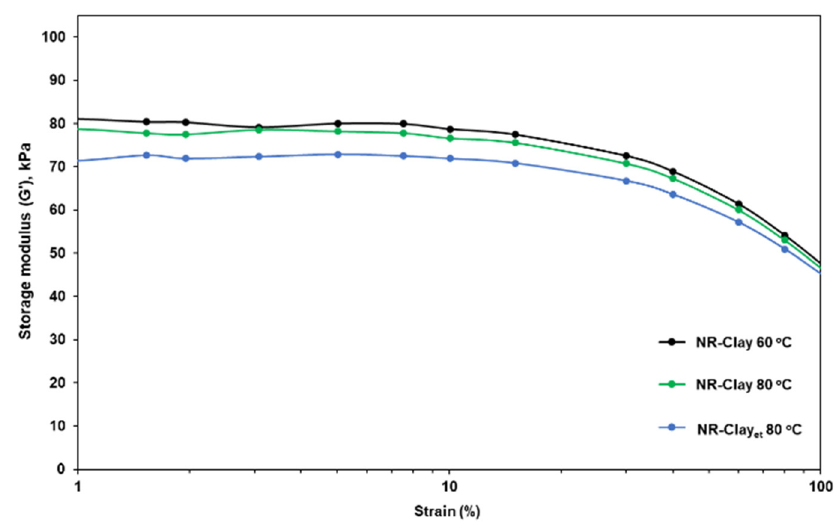
Figure 1. Storage modulus (G ′ ) against %strain (1–100%) of NR, NR-Clay composites at the various mixing temperature (60 ° C, 80 ° C) and NR-Clay composites using Et-OH dispersed bentonite clay.